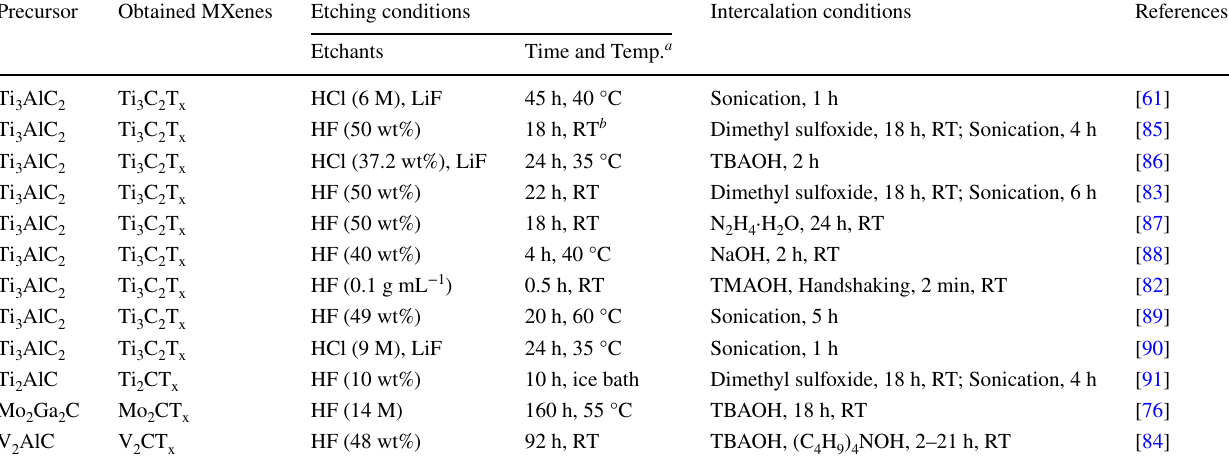
Table 2 Summary of intercalation conditions used for the preparation of MXenes through etching methods